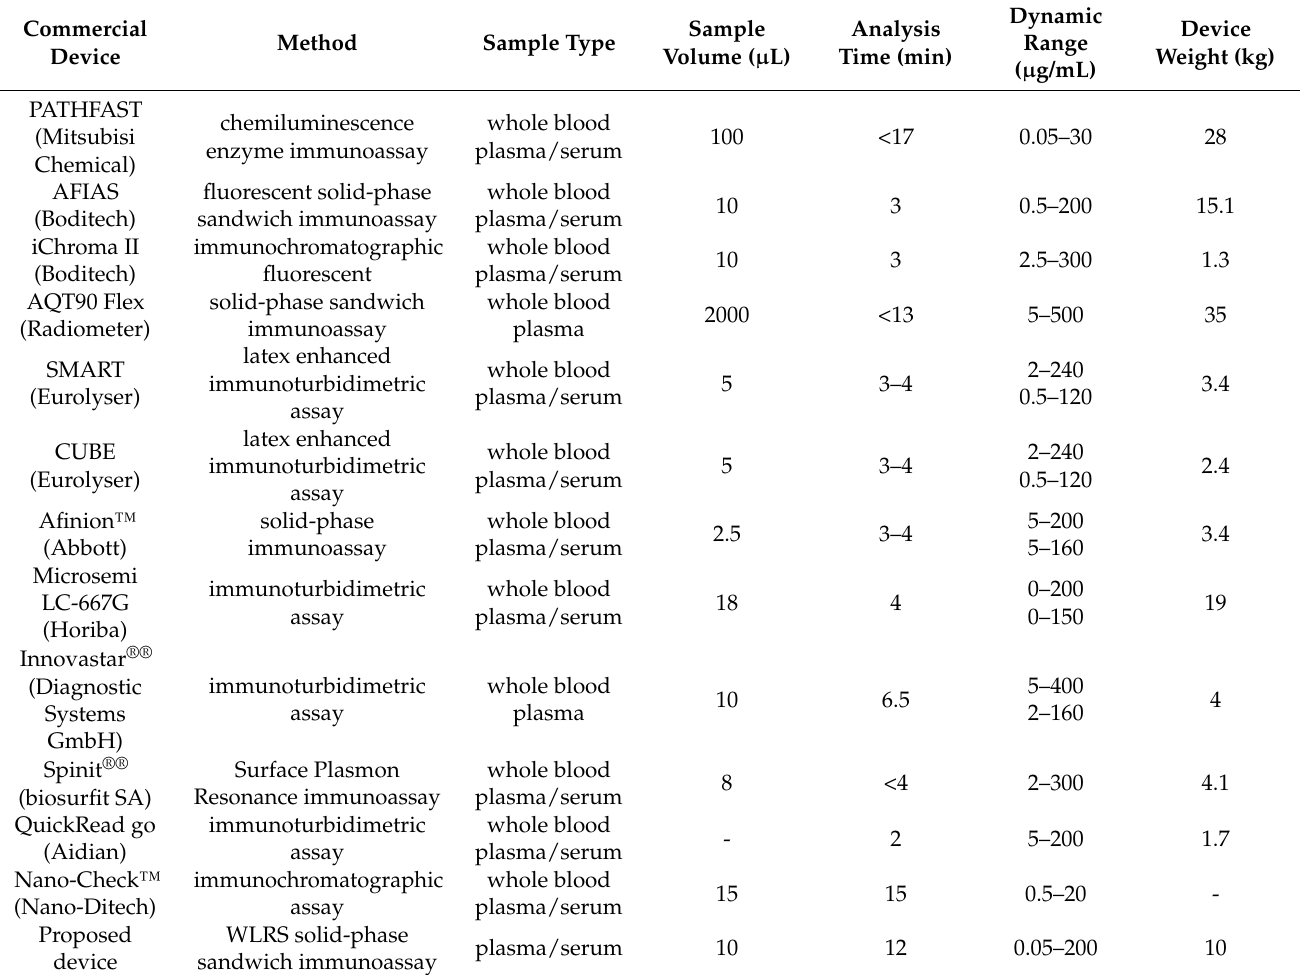
Table 2. Comparison of the proposed PoC device with commercially available PoC devices for the determination of